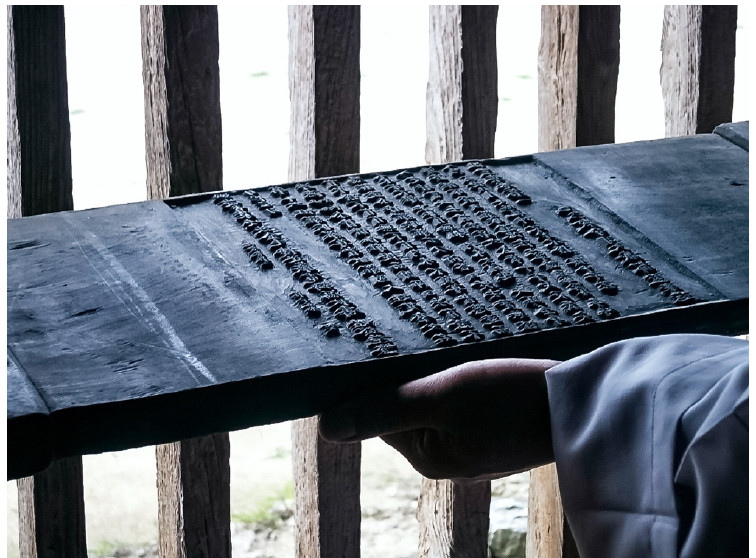
Figure 1. Last zh ā ng 張 (printing surface) of the first juàn 卷 (fascicle) of the ZTJ , where the Figure 1. Last zh¯ang 張 (printing surface) of the first ju à n 卷 (fascicle) of the ZTJ , where the inscrip- inscription related to the date of the carving of the Goryeo edition (“ 乙巳歲分司大藏都監彫造。 ”) is tion related to the date of the carving of the Goryeo edition (“ 乙 巳 歲 分 司 大 藏 都 監 彫 造 。 ”) is found found (photograph by Christoph Anderl). (photograph by Christoph